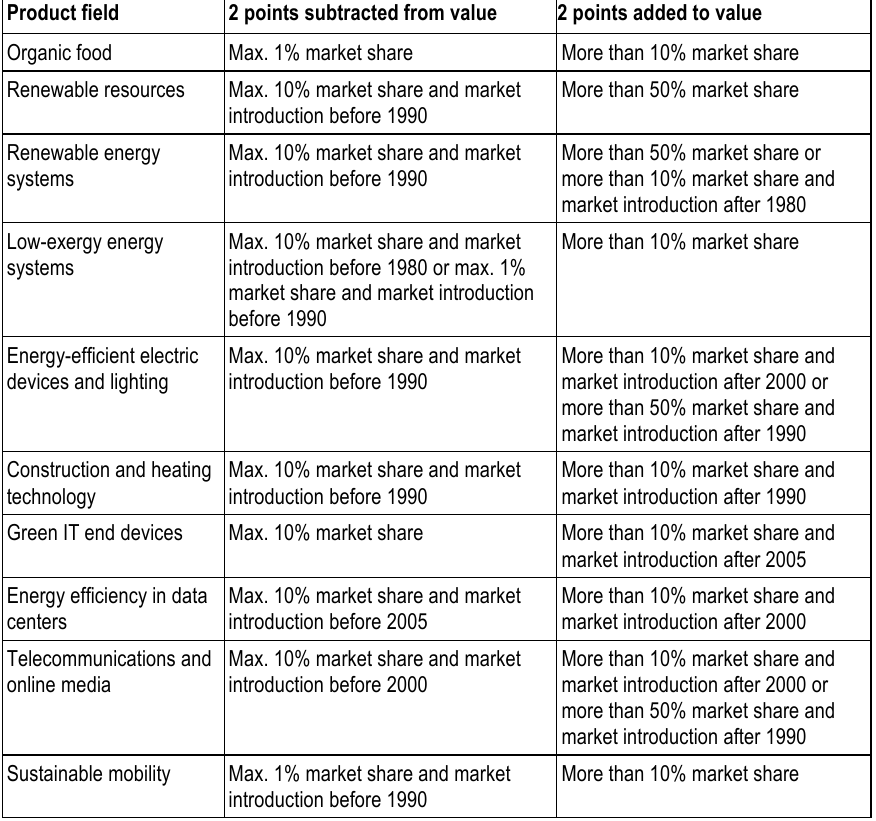
Table 2. Construction of the dependent variable “diffusion dynamics”